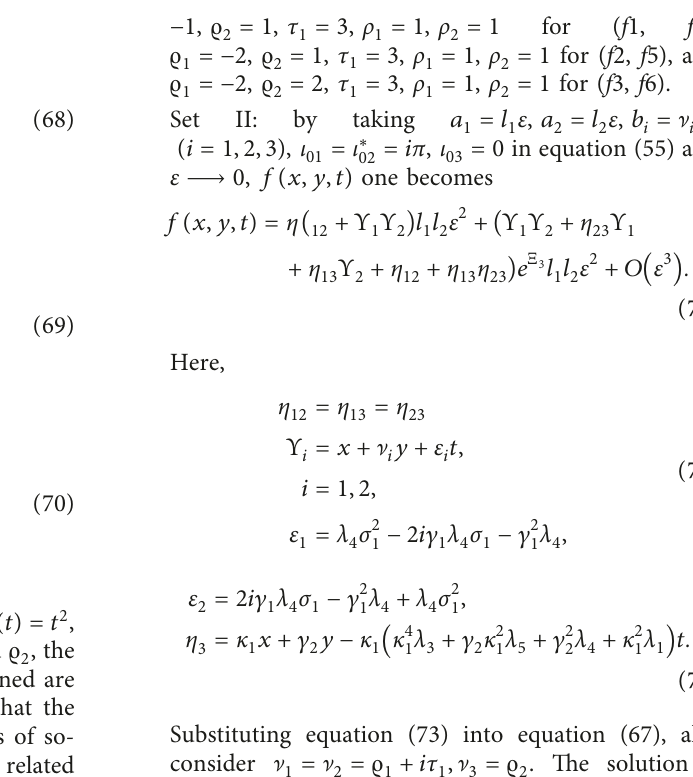
Figure 12: Plots of equation (61) by taking λ (f) f